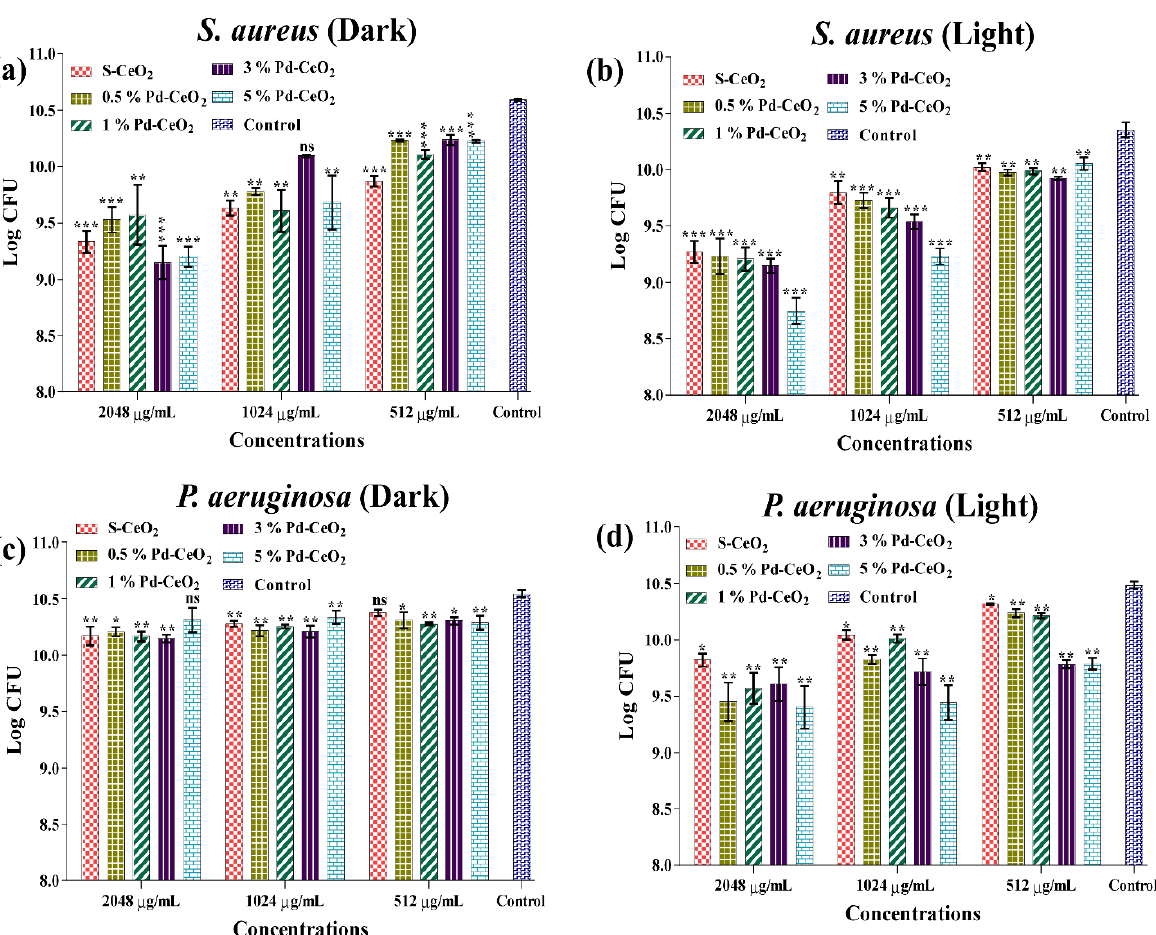
Figure 7. Log reduction of the S. aureus treated with different concentrations of S − CeO 2 NPs and Pd − CeO 2 NPs incubated under ( a ) dark and ( b ) light conditions. Log reduction of the P. aeruginosa treated with different concentrations of S − CeO 2 NPs and Pd − CeO 2 NPs incubated under ( c ) dark conditions and ( d ) light conditions, where ***, **, and * imply significance at p < 0.0001, p < 0.01, and p < 0.05, respectively, while ns means non-significant.